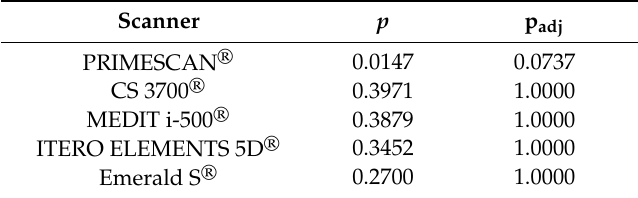
Table 6. Comparisons between models (M) in each group of scanners (row p-values and adjusted for multiple